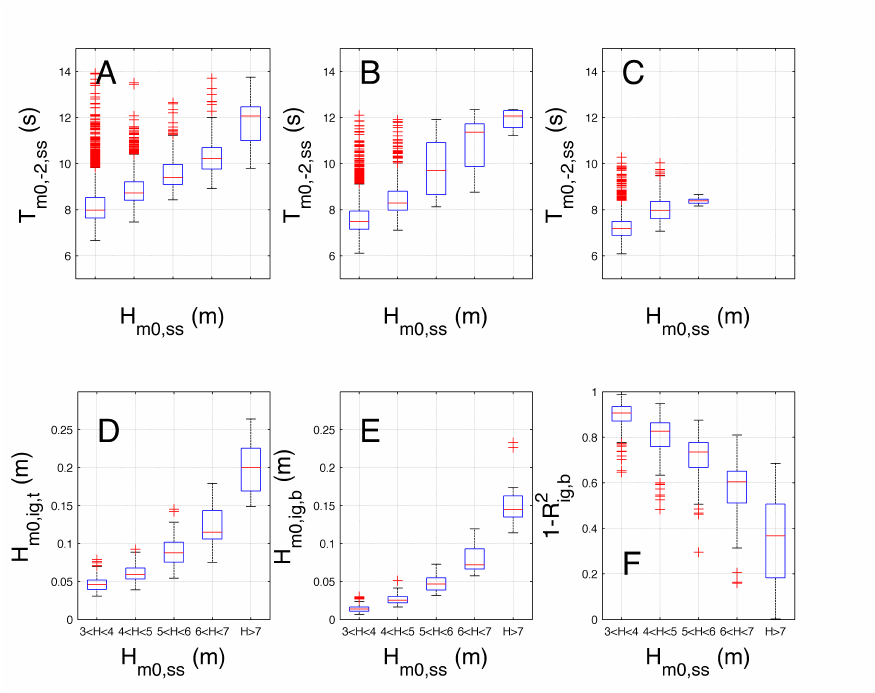
Figure 9. ( A ) Box-whisker plot of the mean wave period as function of the binned sea-swell wave height at A12. ( B ) Mean wave period at station Q1. ( C ) Mean wave period at station EUR. ( D ) Box-whisker plot of the total IG wave height as a function of the binned sea-swell wave height at A12 with σ θ , ss ≤ 30 ◦ . ( E ) Similar for the bound IG wave height. ( F ) Corresponding box-whisker plot of the contribution of the free IG waves to the total IG variance at A12. The box includes the 25 to 75 percentiles with the median in red. Outliers are given by the red plus